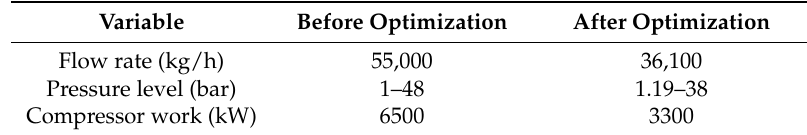
Table 5. Results of optimization.